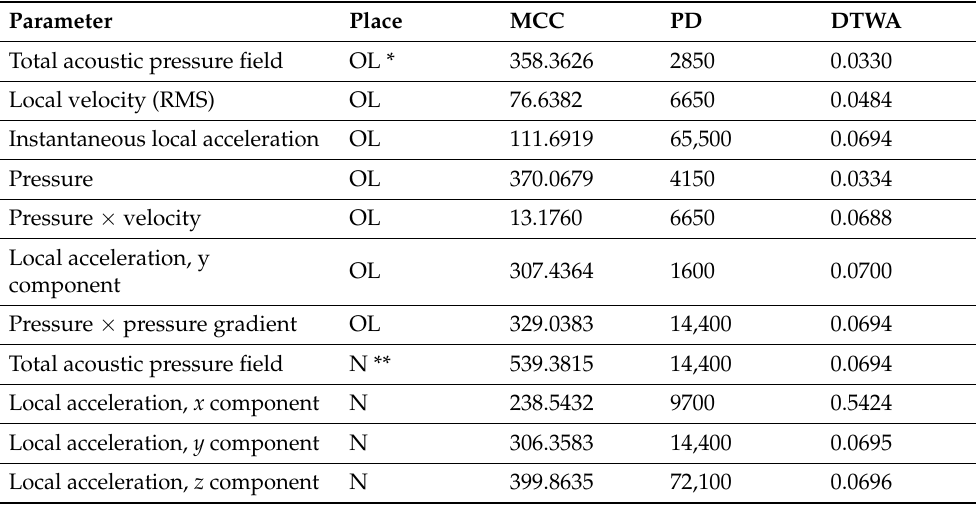
Table 3. Cross-correlation between various parameters and the olfactory deposition. Parameter Place MCC PD DTWA Total acoustic pressure field OL * 358.3626 2850 0.0330 Local velocity (RMS) OL 76.6382 6650 0.0484 Instantaneous local acceleration OL 111.6919 65,500 Pressure OL